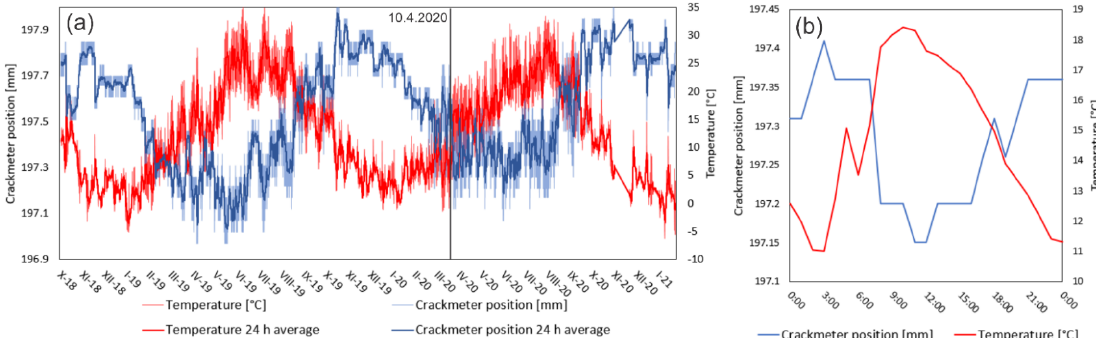
Figure 7. Measured in situ temperature and crack opening at the Pastý ˇ rská rock site. (a) Whole time series with annual amplitudes, (b) ex- ample of the diurnal amplitude measured on 10 April 2020. From the plot in panel (a) , the annual temperature and crackmeter position amplitude may be observed. The plot in panel (b) shows the diurnal temperature and crackmeter position